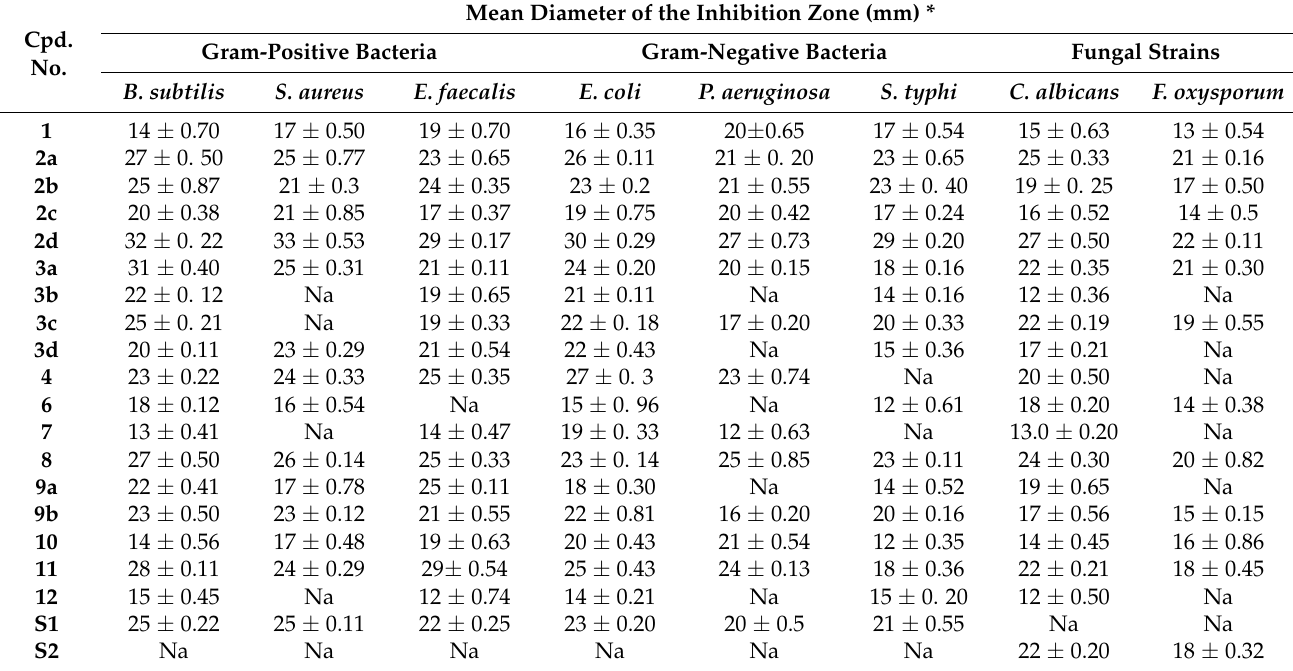
Table 1. In vitro antimicrobial activity of the synthesized compounds with the mean diameter of the inhibition zone (mm).